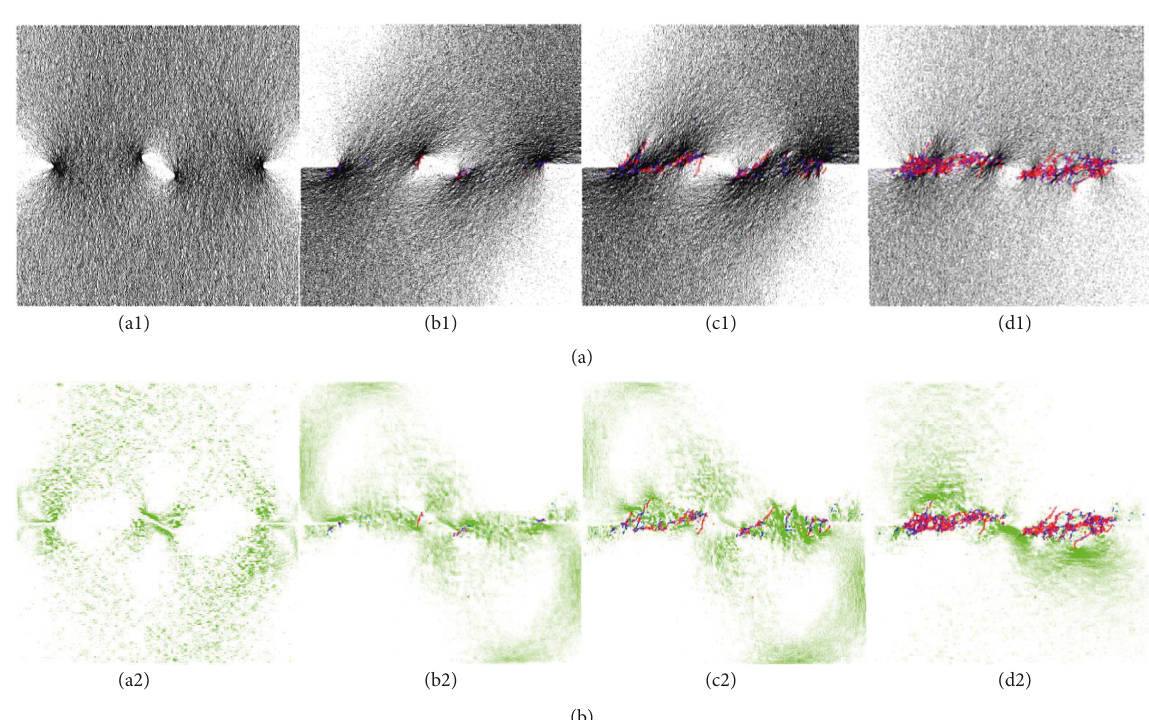
Figure 18: Contact force evolution for Sample A30 (shear direction: right to left): (a) compressive contact force; (b) tensile contact